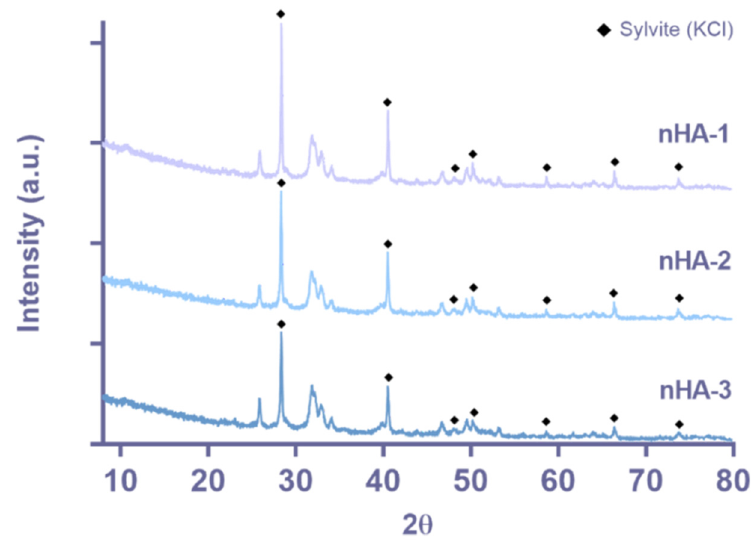
Figure 3. XRD diffractograms for nHA-1, -2 and -3.